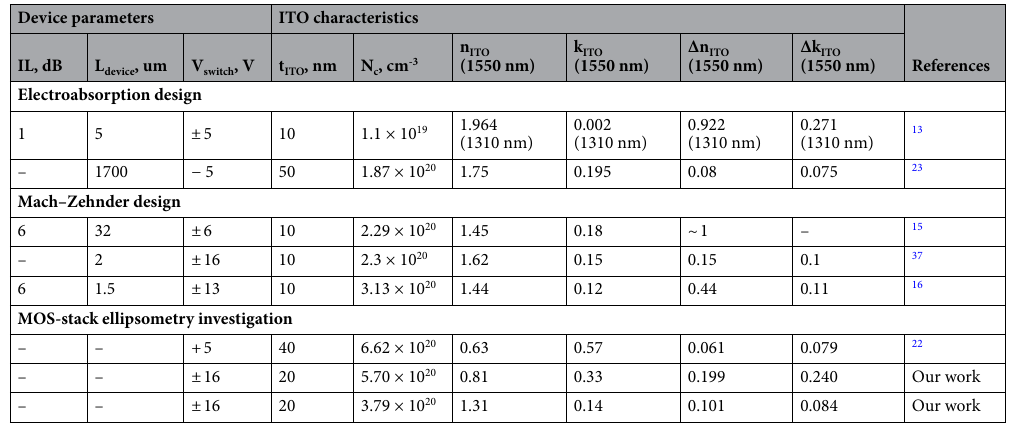
Device parameters ITO